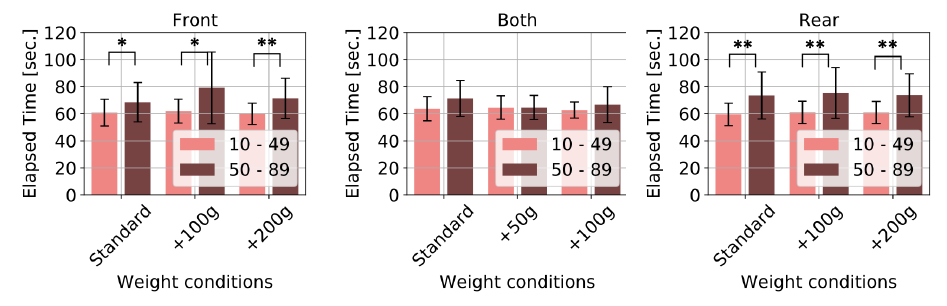
Figure 3. Game completion time for female participants. (*: p < 0.05, **: p <